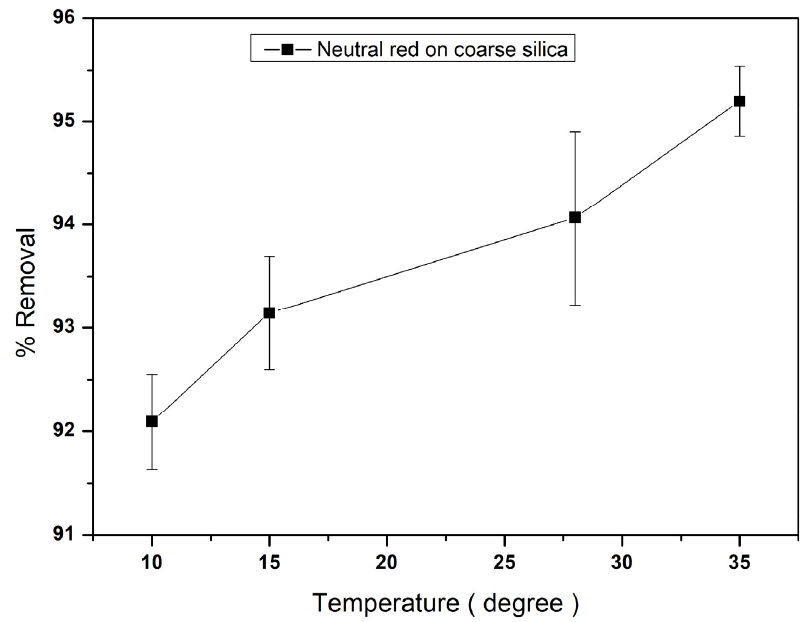
Figure 5. Effect of temperature on the adsorption of 50 mL/50 ppm of neutral red on 5 g silica gel (60–120 mesh) with a contact time of 30 min. Table 4. Thermodynamic parameters for the neutral red adsorption on coarse silica